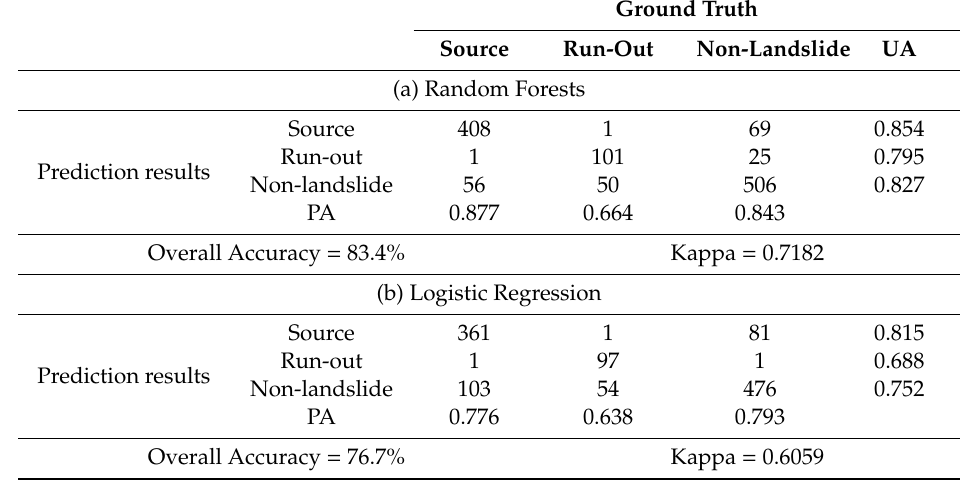
Table 5. Confusion matrix result of Model-1 using the Max–Min sampling strategy without the cost setting.